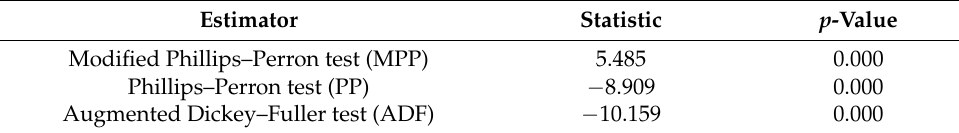
Table 7. Pedroni cointegration test.